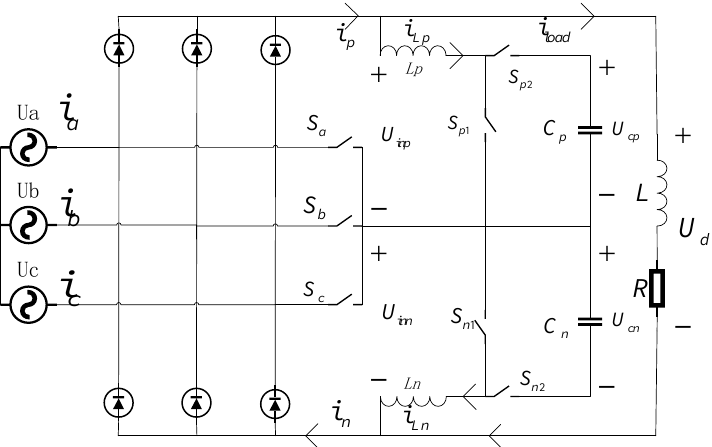
Figure 7. DC-side parallel APF topology